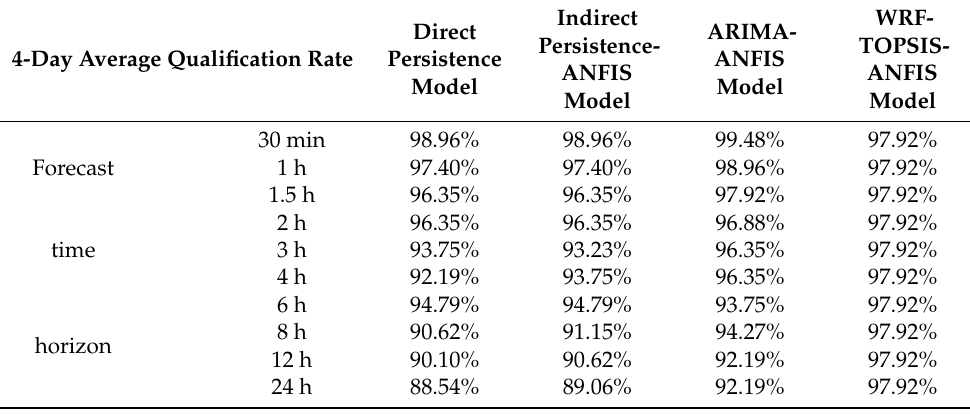
Table 18. Four-day average qualification rate for the wind power forecasting using the direct persistence, indirect persistence-ANFIS, ARIMA-ANFIS, and WRF-TOPSIS-ANFIS models applied to the 4-day test